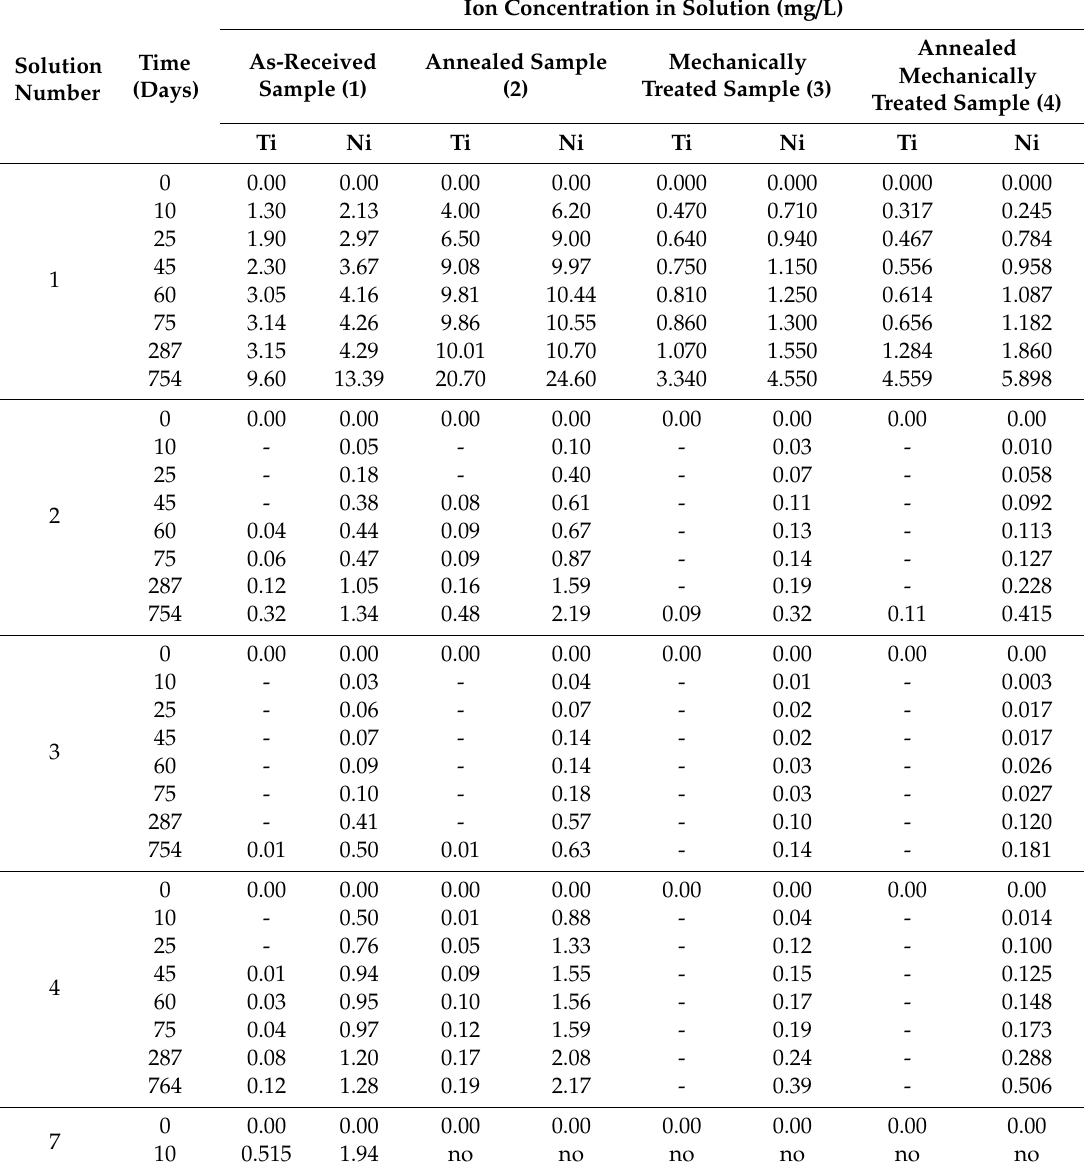
Table 2. Metal concentrations in various solutions measured by inductively coupled plasma atomic emission spectroscopy (ICP-AES) for various immersion times and samples